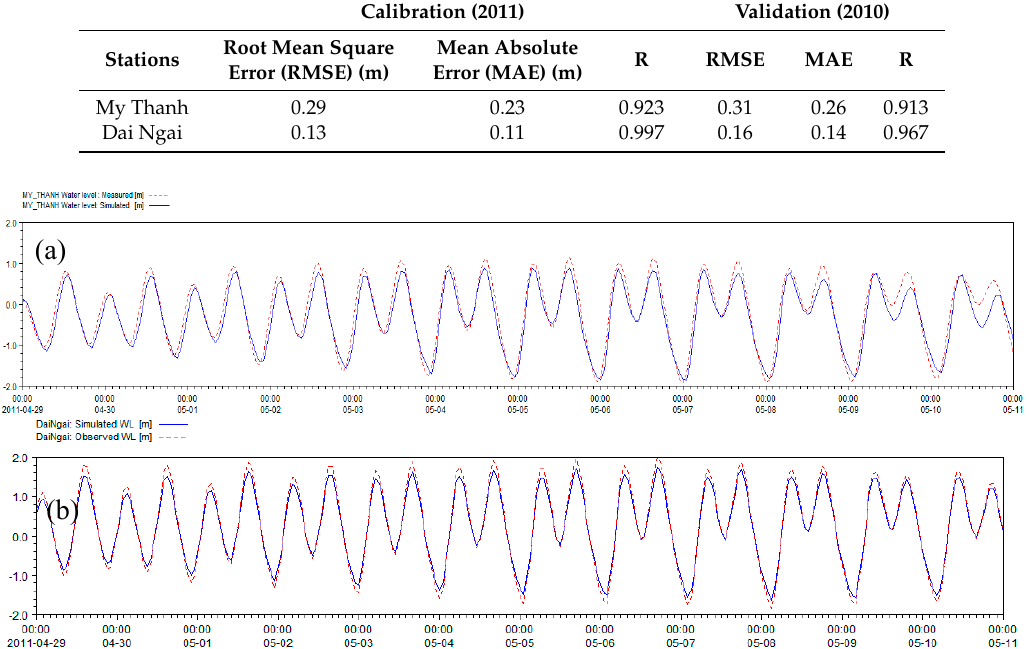
Figure 5. Calibration of water level at My Thanh ( a ) and Dai Ngai station ( b ).